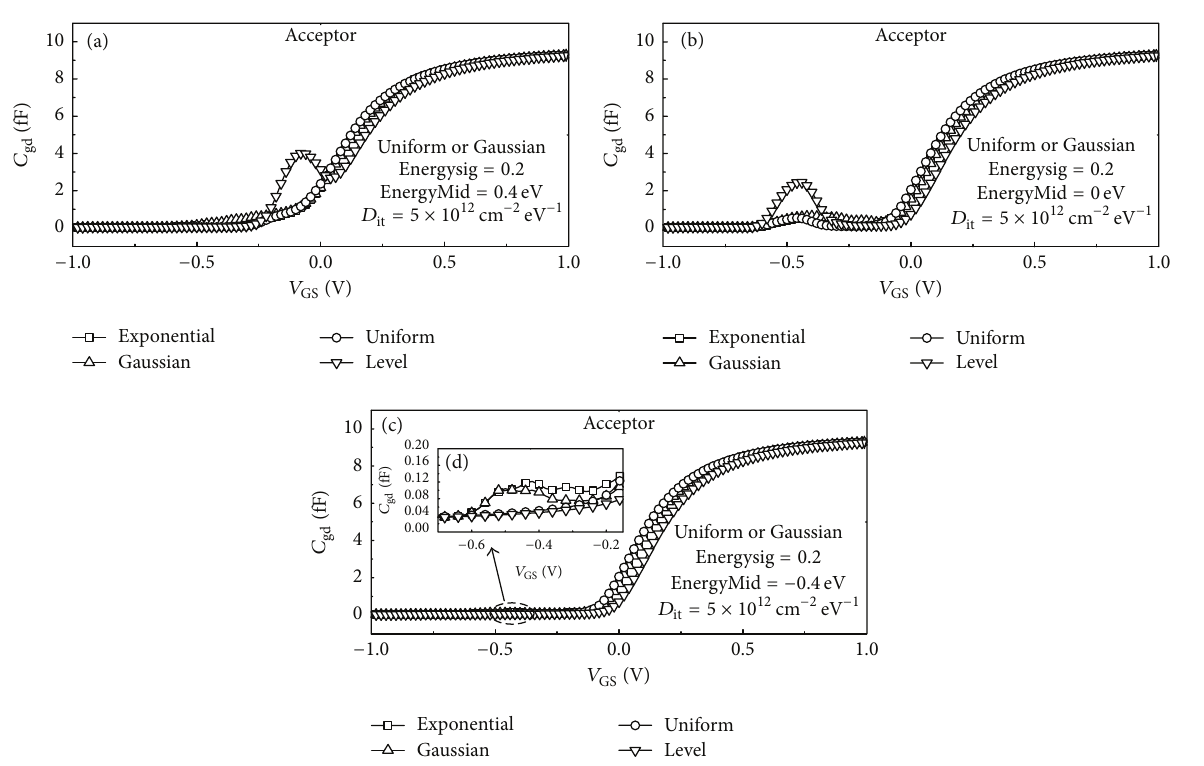
Figure 17: Four types of energetic distribution for acceptor-type are located at three representative level positions which are (a) EnergyMid = 0.4 eV ( 𝐸 𝑖 + 0.4 eV), (b) EnergyMid = 0.0 eV, and (c) EnergyMid = 0.4 eV, respectively.